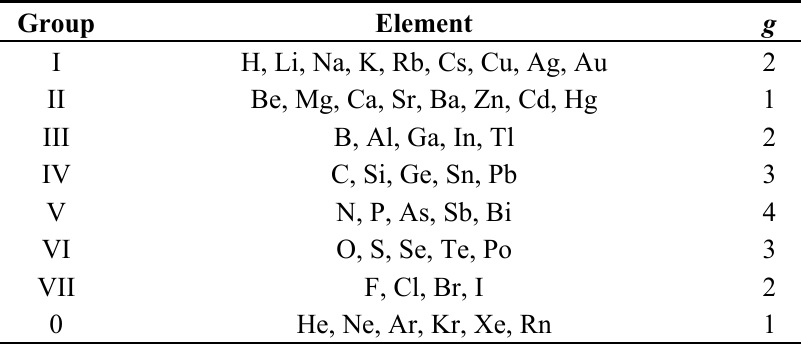
Table 1. Electron energy level degeneracy of some